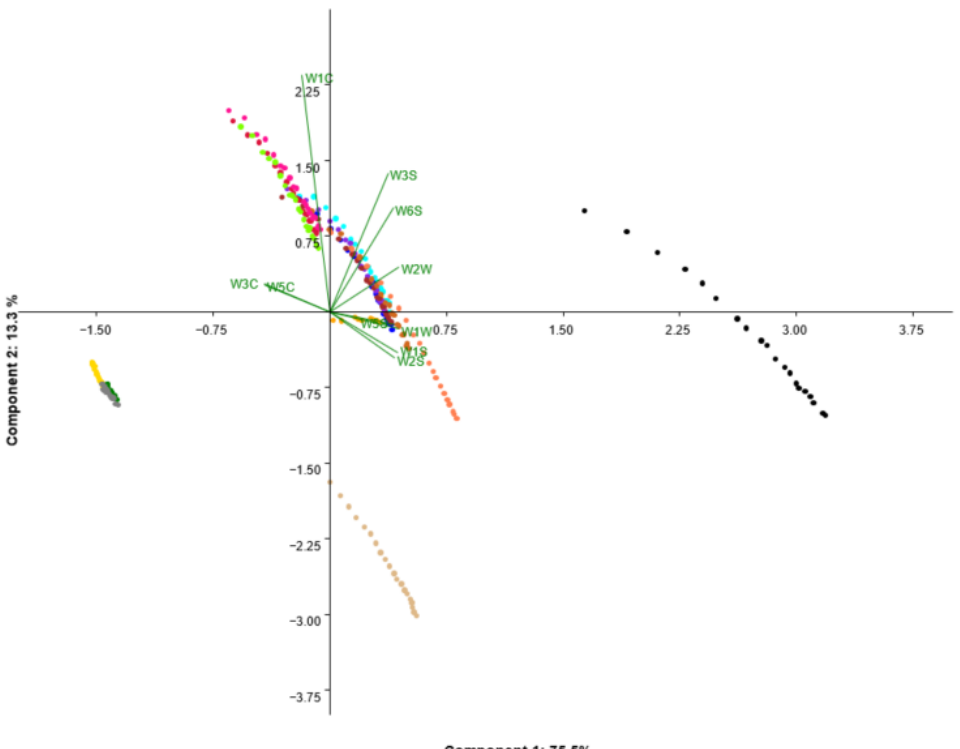
Figure 7. Biplot of PCA based on electronic-nose data for the 15 samples reported in Table 1. Loading plot represents the responses of e-nose sensors as described in Table 2. Colour samples are: 1, orange; 2, aqua; 3, blue; 4, blue-violet; 5, brown; 6, burlywood; 7, chocolate; 8, coral; 9, crimson; 10, deep pink; 11. chartreuse; 12. gold; 13. green; 14. grey; 15. black.